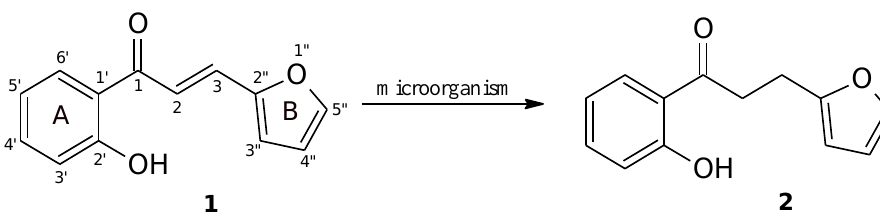
Figure 2. Biotransformation of 3-(2”-furyl)-1-(2’-hydroxyphenyl)-prop-2-en-1-one ( 1 ) by selected yeast cultures. The ring designations and the numbering of carbon atoms have been placed on compound 1 .